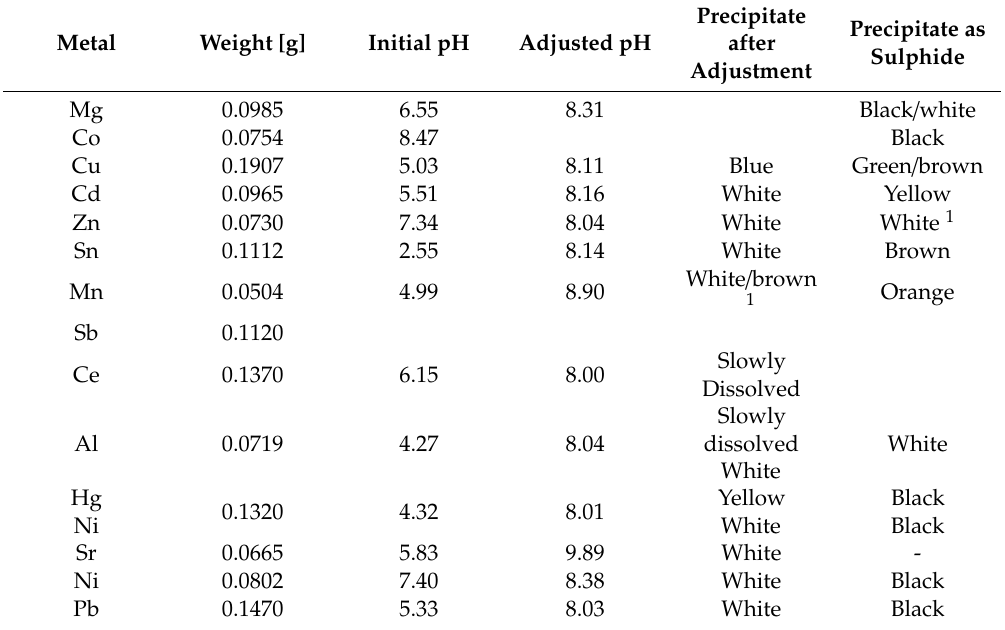
Table 5. Precipitation by pH adjustment alone and sulphide precipitation by initial pH